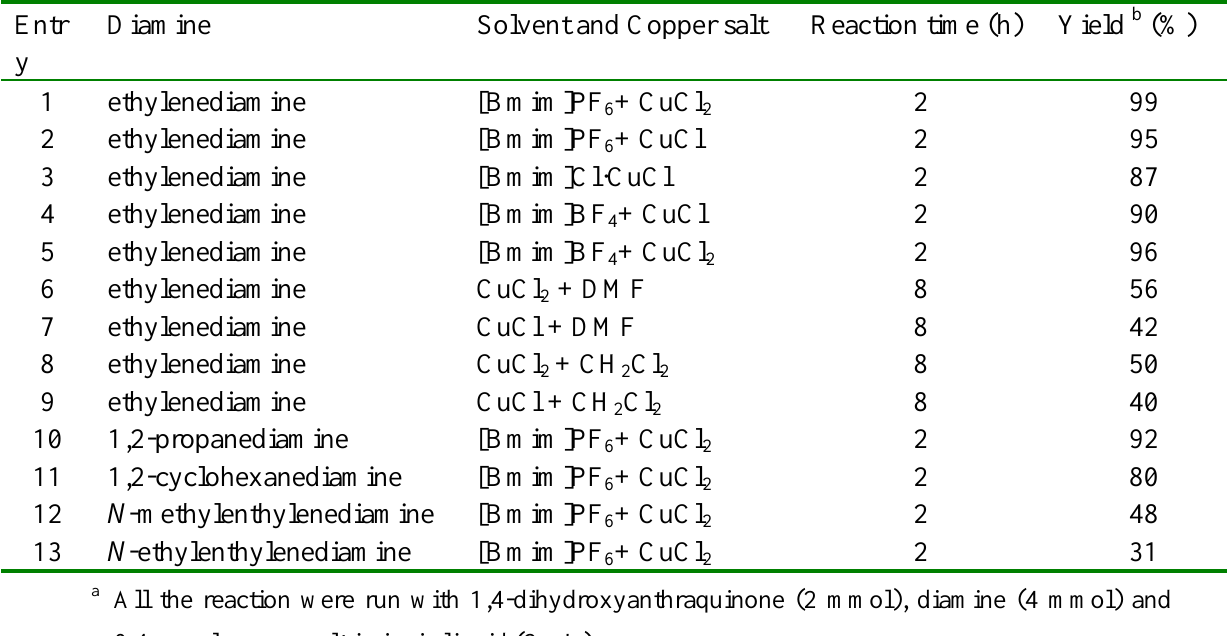
Table 1. Reaction of 1,4-Dihydroxyanthraquinone and Diamines catalyzedcopper salt in ionic liquids a